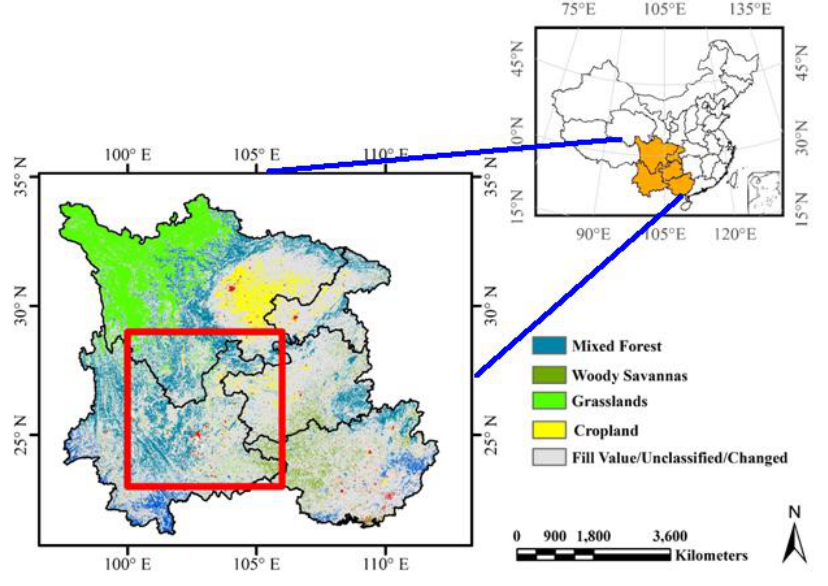
Figure 1. Unchanged land cover types in the study area. The first layer of MODIS Land Cover data was used to create the land cover. Red square defines the study